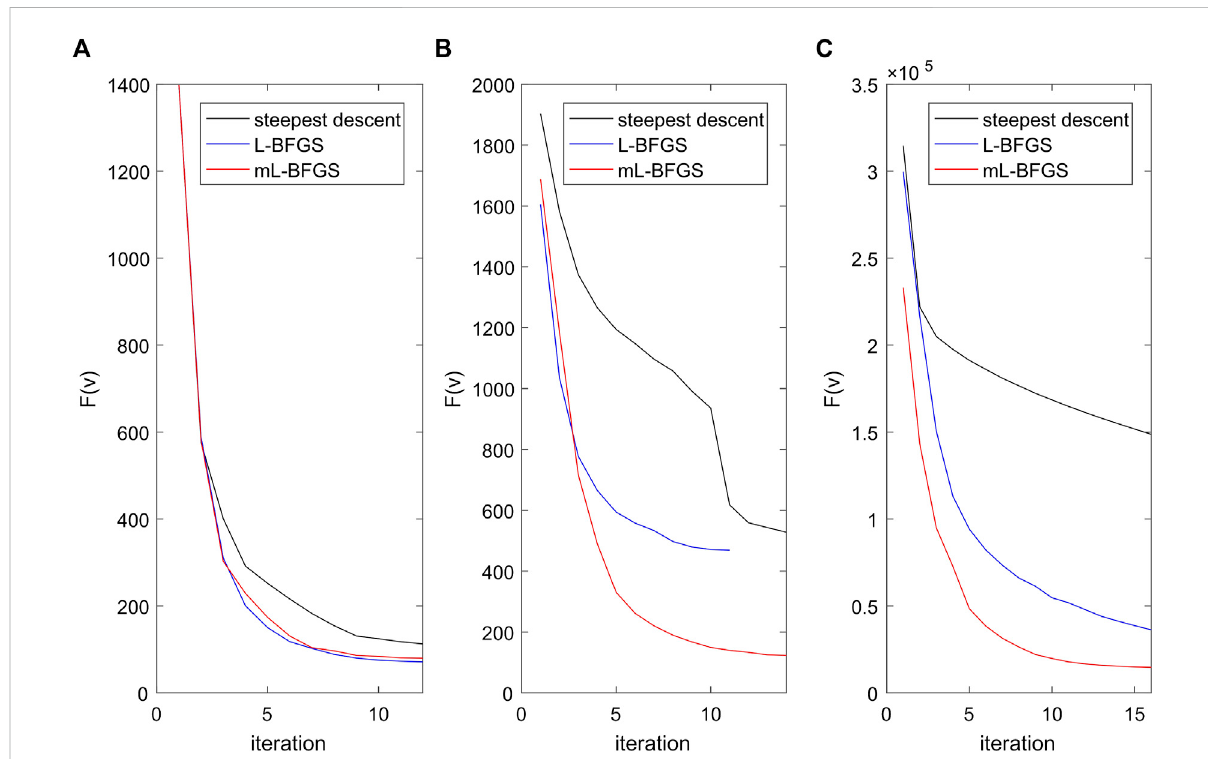
FIGURE 4 The convergence curves of the Marmousi model test using (A) 0 – 10 Hz, (B) 0 – 15 Hz, and (C) un fi ltered data. Black line: steepest descent method; blue line: L-BFGS method; red line: mL-BFGS